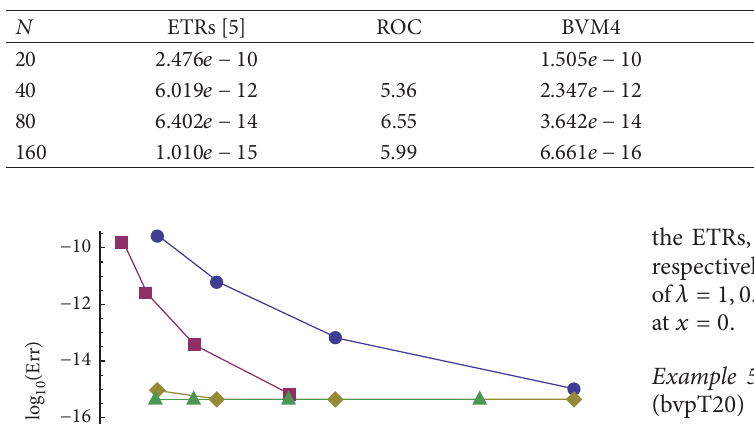
Table 4: Maximum errors for different step sizes for Example 3.